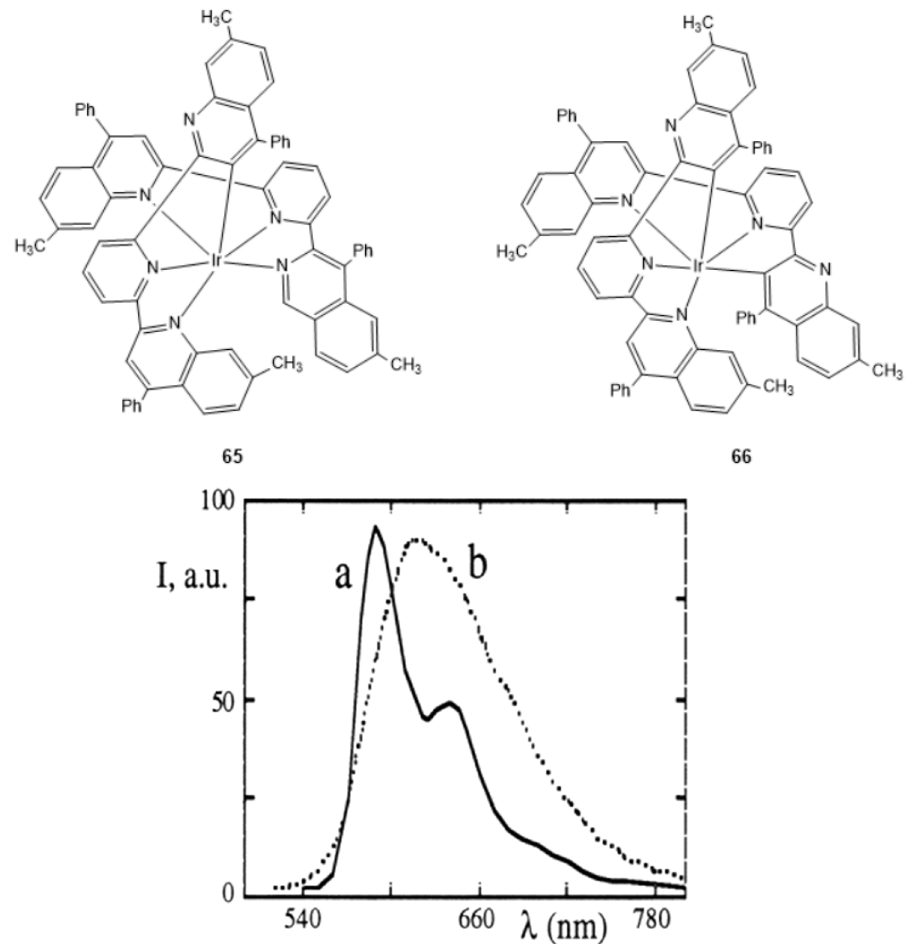
Figure 4. Structures of Ir(III) complexes and emission spectra [79], [Adapted with permission from (Mamo et al.). Copyright (2006) American Chemical Society].